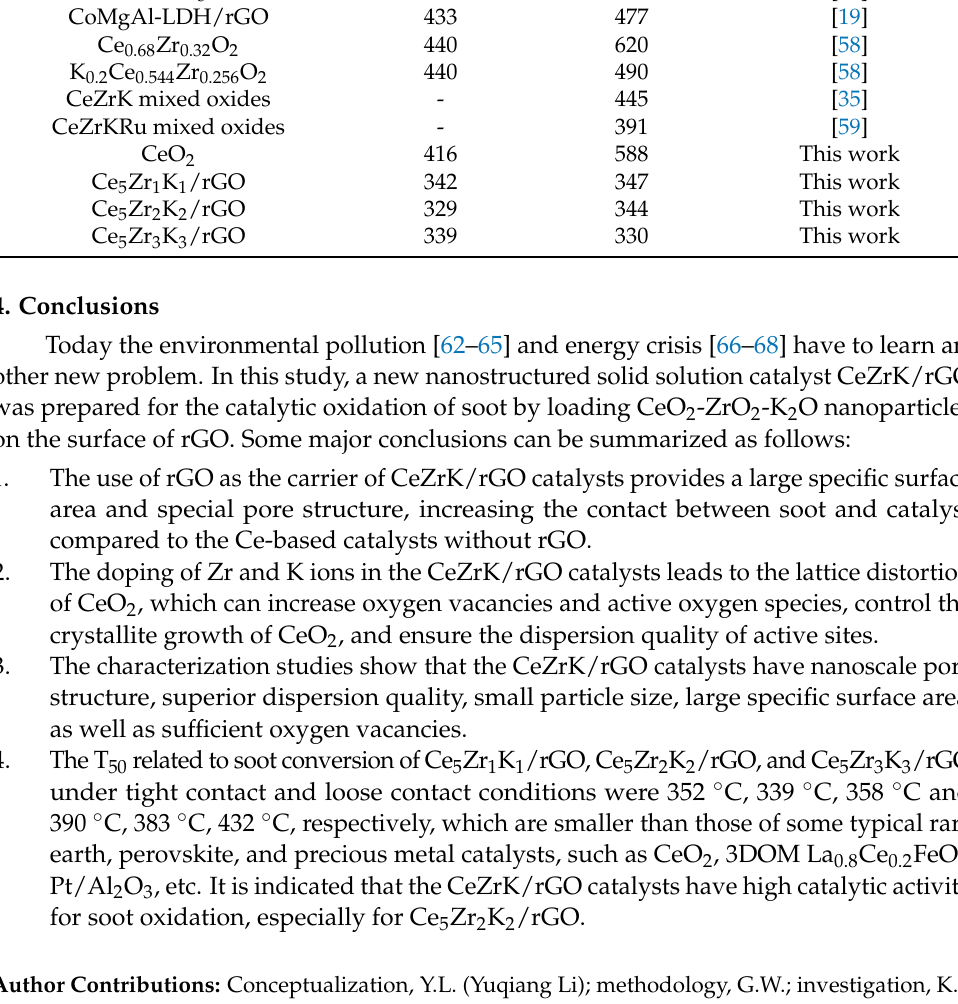
Table 6. T m of various catalysts for soot oxidation under tight contact and loose contact conditions. Catalyst Name